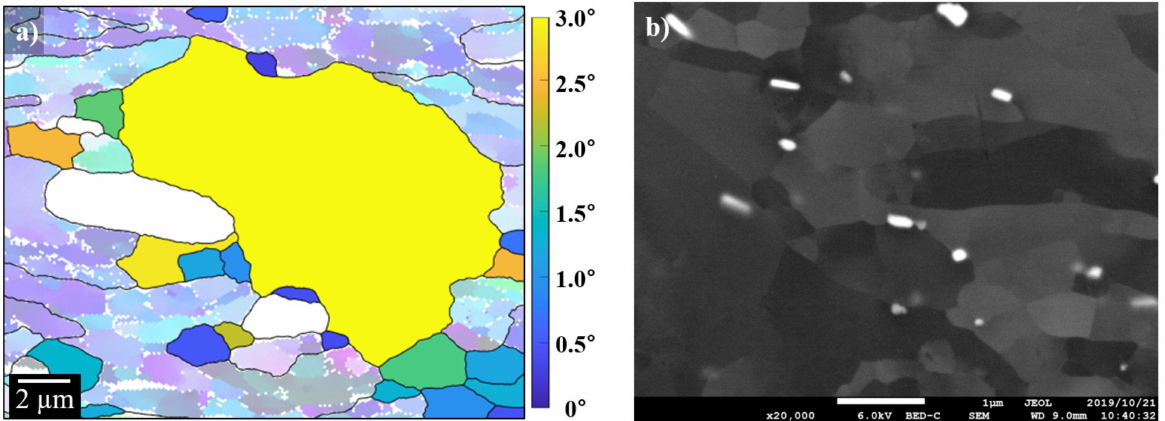
Figure 17. Grain orientation spread (GOS) map overlaid with IPF map in AM9 annealed at 300 ◦ C for 30 s shows growth of recrystallized grain ( a ) in deformation zone around a coarse particle and ( b ) in dispersoid